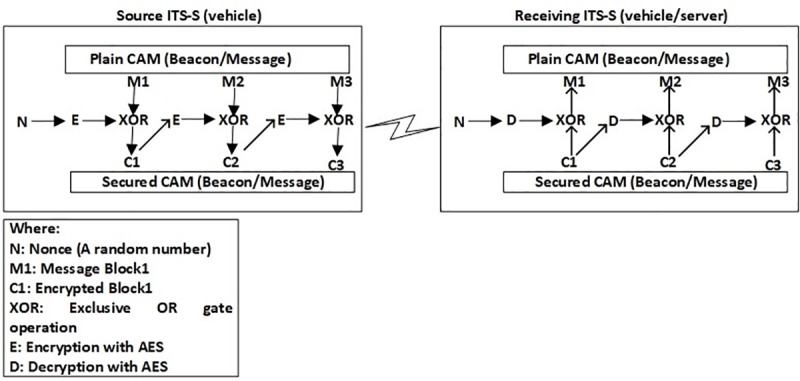
ASPA, CFM operation.